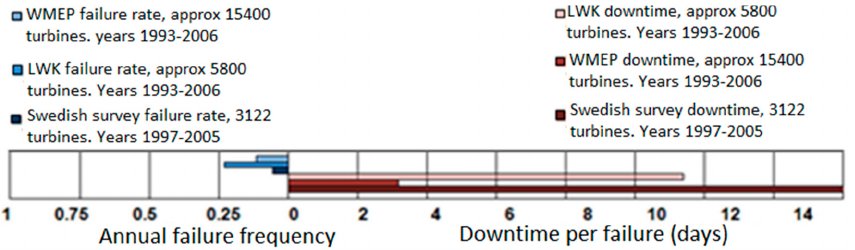
Figure 9. Annual failure frequency and downtime per failure for rotor-blades sub-system [53].